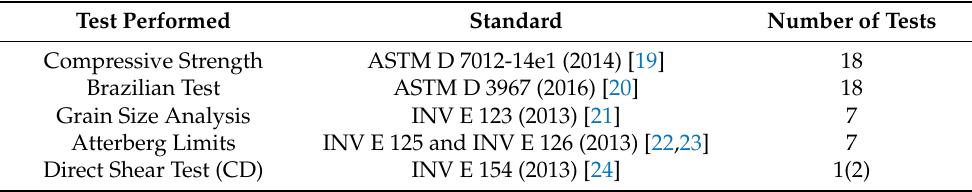
Table 1. Tests performed on the drilling samples, applied standards and number of tests. Test Performed Standard Number of Tests Compressive Strength ASTM D 7012-14e1 (2014) [19] 18 Brazilian Test ASTM D 3967 (2016) [20] 18 Grain Size Analysis INV E 123 (2013) [21] 7 Atterberg Limits INV E 125 and INV E 126 (2013) [22,23] 7 Direct Shear Test (CD) INV E 154 (2013) [24]